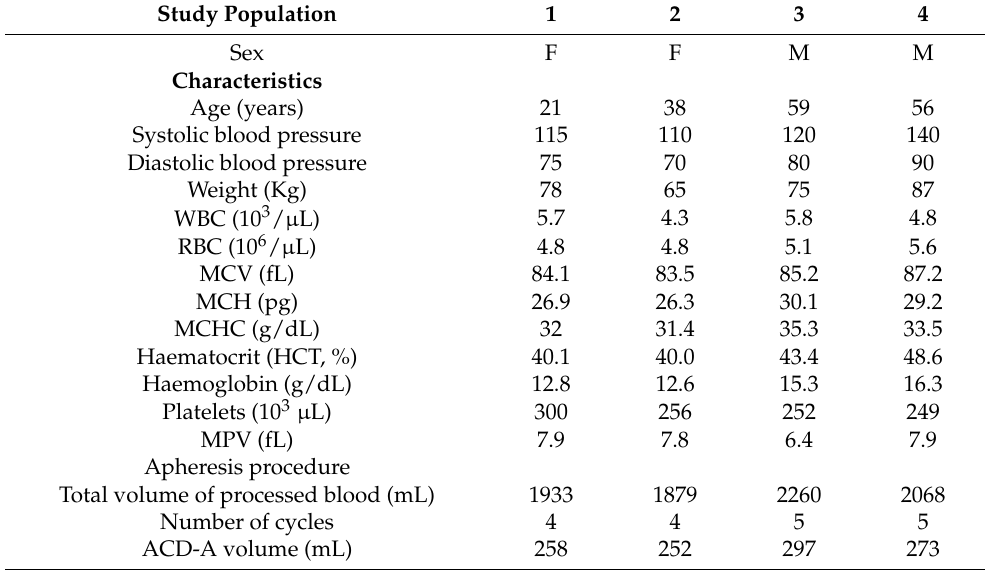
Table A1. Study population characteristics and procedure